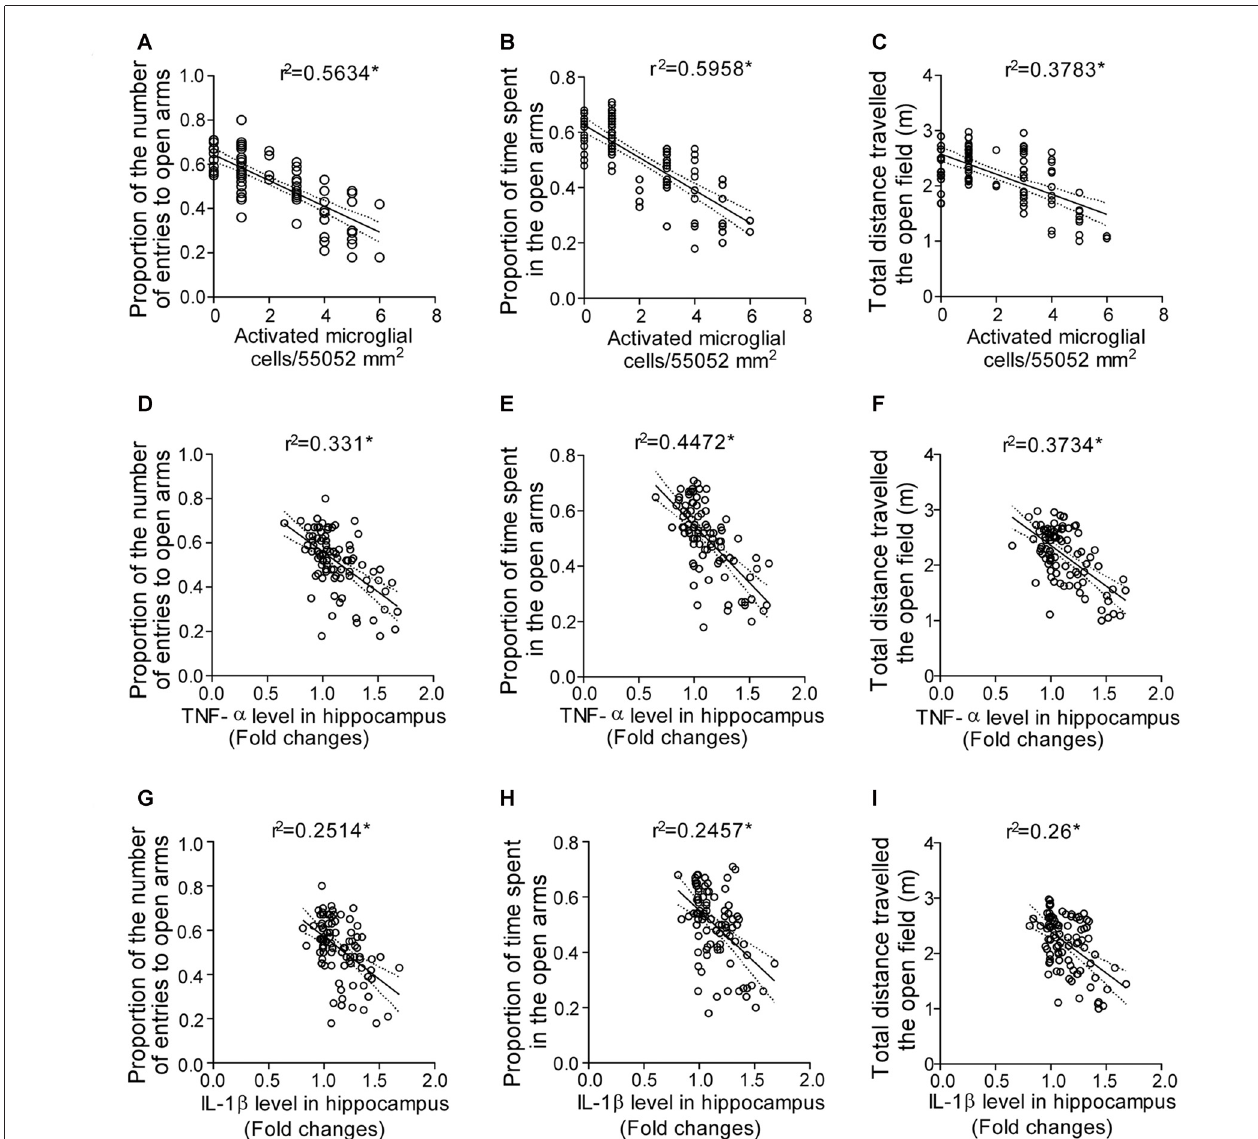
FIGURE 8 | Correlation analysis predicting the interaction between the anxious behavior, pro-inflammatory cytokines and activated microglia cell during SD. Interaction between the anxious behavior and activated microglial cell as shown by correlation between (A) proportion of the number of entries in the open arms and activated microglial cell count in the hippocampus; (B) proportion of the time spent in the open arms and activated microglial cell count in the hippocampus; (C) total distance traveled in the OF and activated microglial cell count in the hippocampus. Finally, the interaction between the anxious behavior and pro-inflammatory cytokine levels as shown by correlation between (D) proportion of the number of entries in the open arms and TNF- α level in hippocampus; (E) proportion of the time spent in the open arms and TNF- α level in hippocampus; (F) total distance traveled in the OF and TNF- α level in hippocampus; (G) proportion of the number of entries in the open arms and IL-1 β level in hippocampus; (H) proportion of the time spent in the open arms and IL-1 β level in hippocampus; (I) total distance traveled in the OF and IL-1 β level in hippocampus. Pearson’s test was applied for correlation analysis. p < 0.05 was considered to be statistically